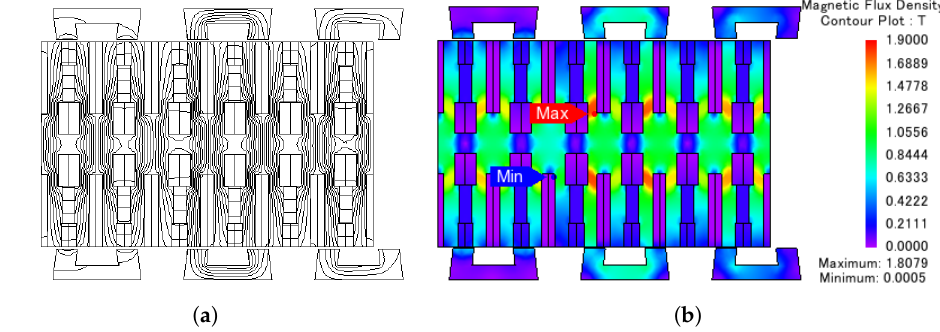
Figure 4. Flux linkage (DC excitation only) ( a ) flux lines, ( b ) contour plot.